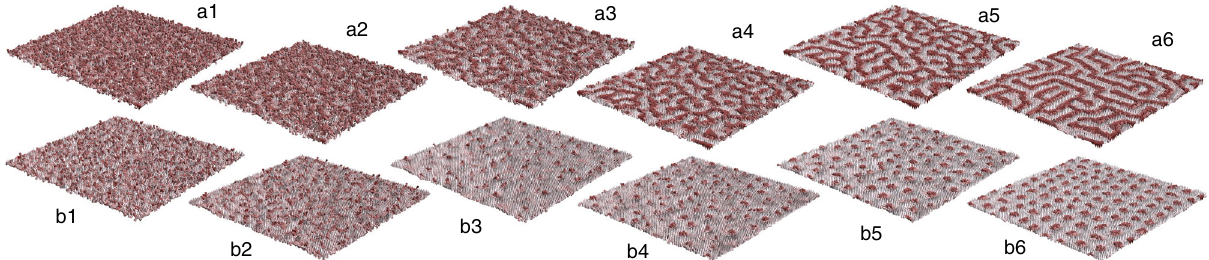
Fig. 1 Spinodal decomposition and nucleation processes in PZT thin fi lms. Time evolution of the dipolar pattern within the middle layer of 80 × 80 × 5 fi lm of Pb(Zr fi eld ( a 1 – a 6) and under 40 × 10 7 V/m applied along [001] pseudo-cubic direction ( b 1 – b 6), as obtained from 0.4 Ti 0.6 )O 3 under zero external molecular dynamics simulations. In each of the two cases, 1 – 6 correspond to 150, 250, 350, 450, 750, and 1500 fs after the quench from 650 K to 10 K, respectively. While a 1 – a 6 indicate the onset of the spinodal instability and development of the labyrinthine pattern, b 1 – b 6 show the nucleation process leading to the bubble domain pattern. Gray (red) dipoles are oriented along [001] ([00 (cid:1) 1]) pseudo-cubic